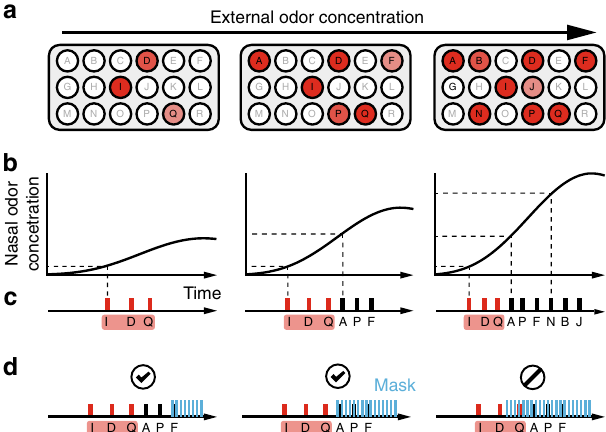
Fig. 1 Primacy coding of odor identity. a Schematic presentation of the patterns of glomerulus (OSN) activation for three concentrations of the same odor. The total number of active glomeruli increases with an increase of odor concentration. b The temporal pro fi les of the odor concentration in the nose during inhalation for three concentrations of the presented stimuli. Dashed lines represent concentration thresholds for representative glomeruli (horizontal) and corresponding response latencies (vertical). c Temporal sequence of glomeruli activation for three different odor concentrations. d Optogenetic mask schematic demonstrating the effect of early relative to odor-evoked temporal